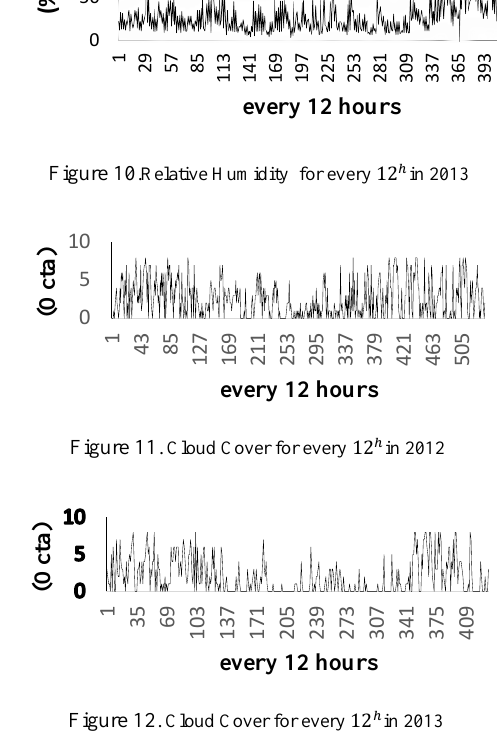
Figure 6 .Wind Speed for every 12 ℎ in 2013